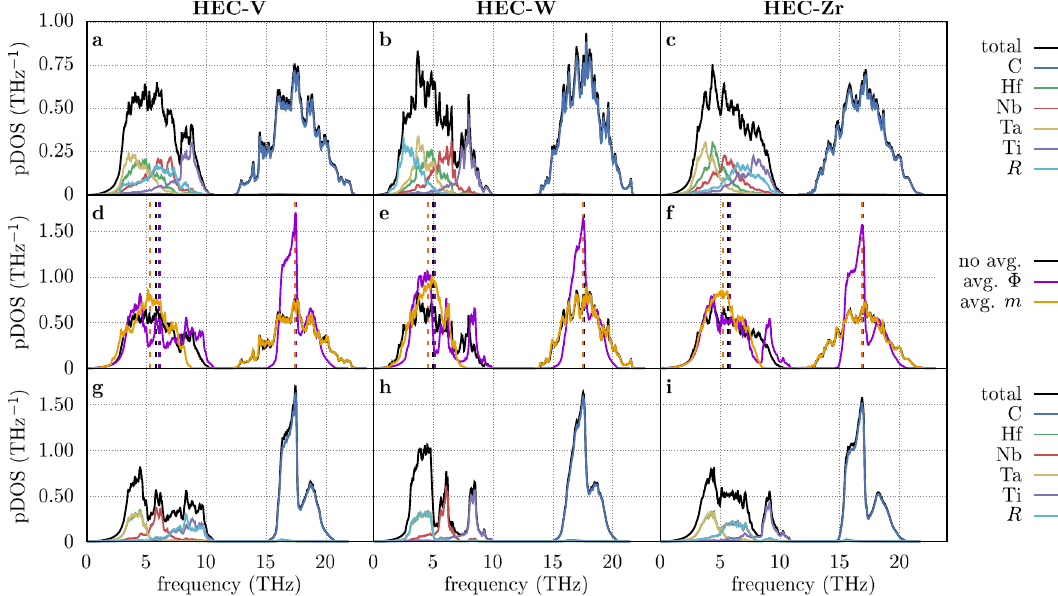
Fig. 2 Phonon densities of states (pDOS). a – c Total pDOS for the high-entropy carbides (HECs) HfNbTaTi R ð Þ C (HEC- R ) for T POCC = 2473 K and their atomic projections. d – f Comparison of the total pDOS without averaging, with averaged force constants Φ , and with averaged cation masses m . Dashed vertical lines denote average frequencies. g – i Total and atom-projected pDOS for the HECs with averaged force constants.